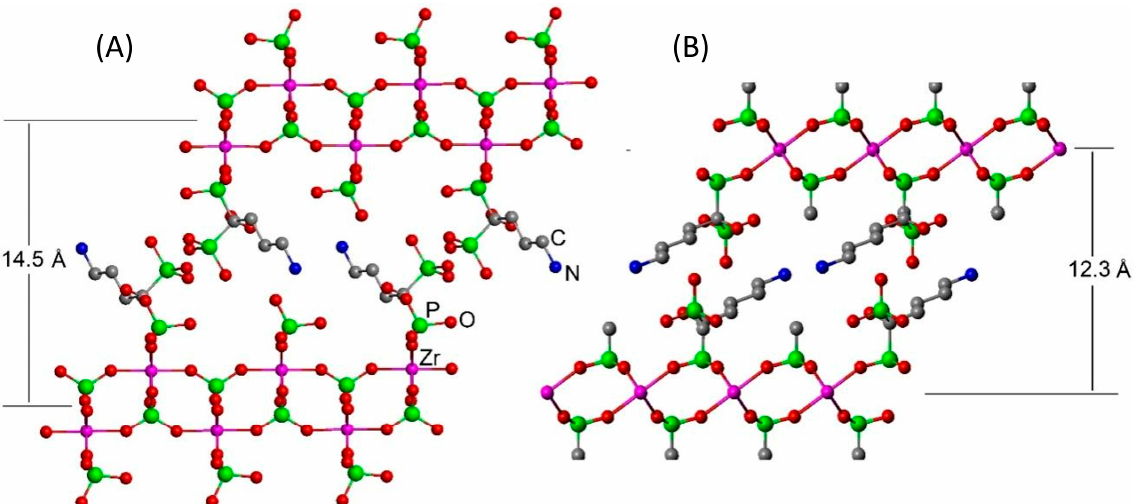
Figure 2. Ideal structural arrangement for the ( A ) gamma- and ( B ) alpha-modified compounds.